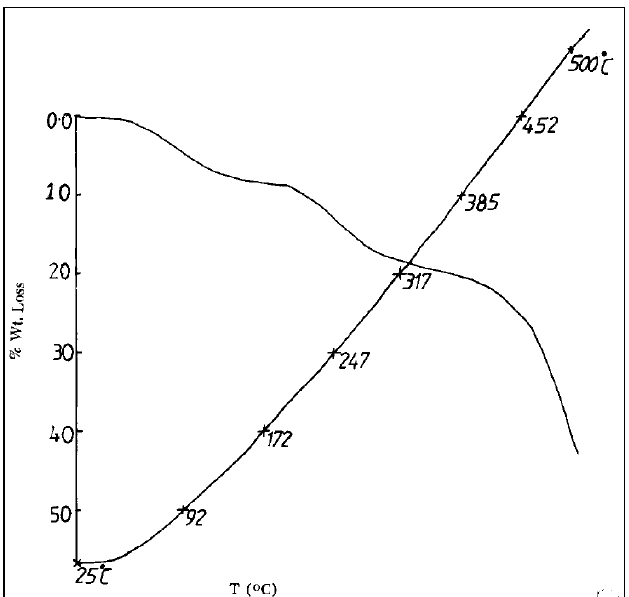
Figure 6. TGA of PAn/HCl prepared by CV method. The TG analysis conditions were the same as used in Figure